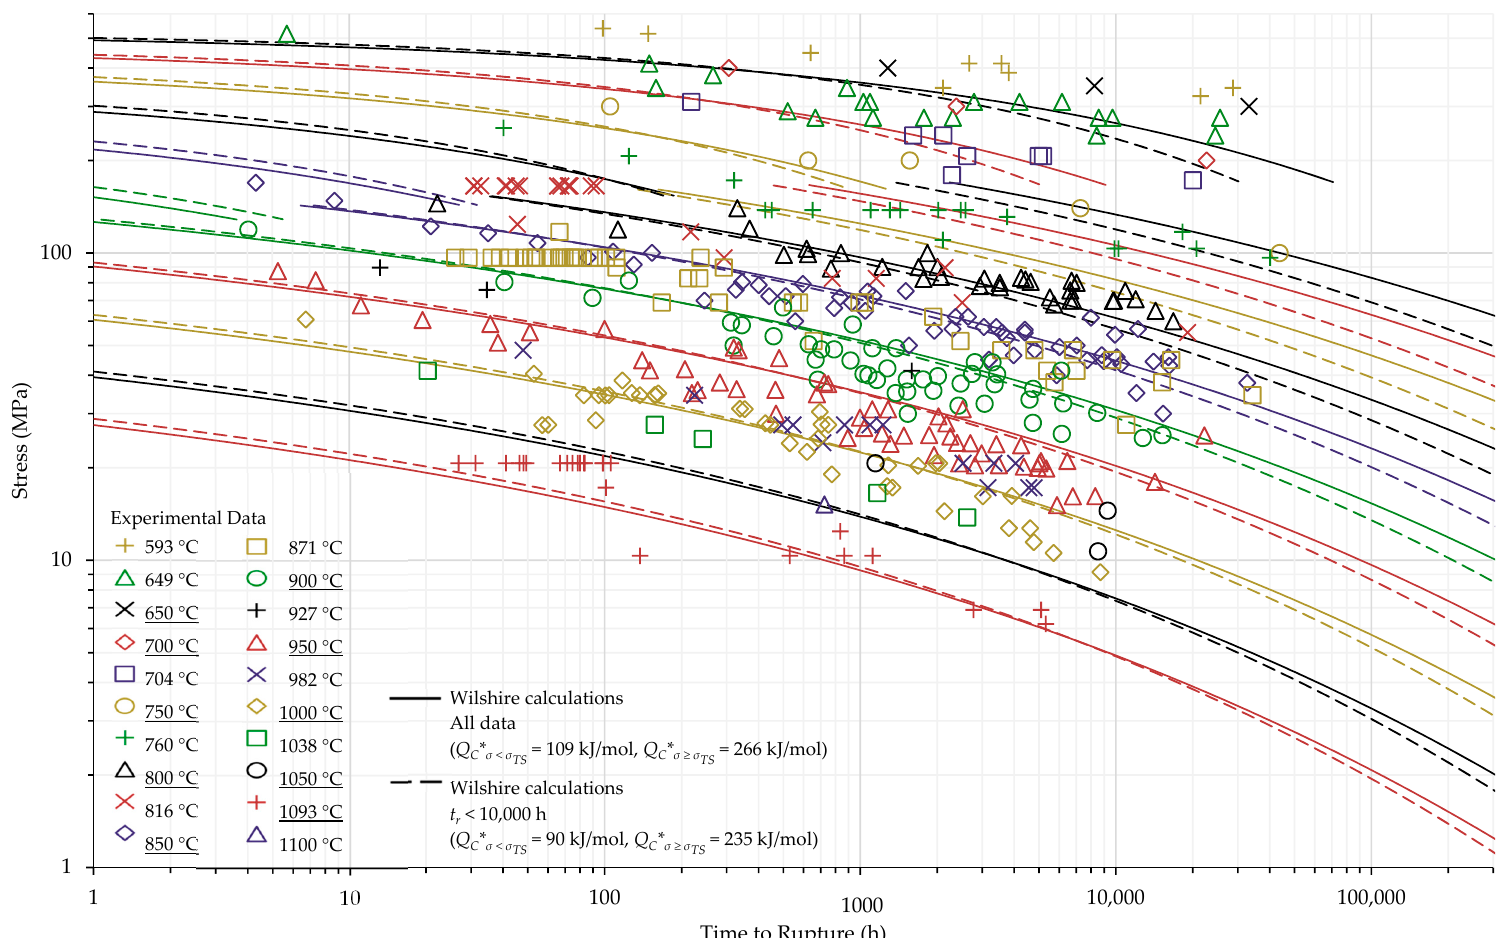
Figure A12. Split region calculations of the Wilshire equation with Q ∗ determined by optimizing the correlation of data on a Wilshire plot for Inconel 617 shown at underlined temperatures.